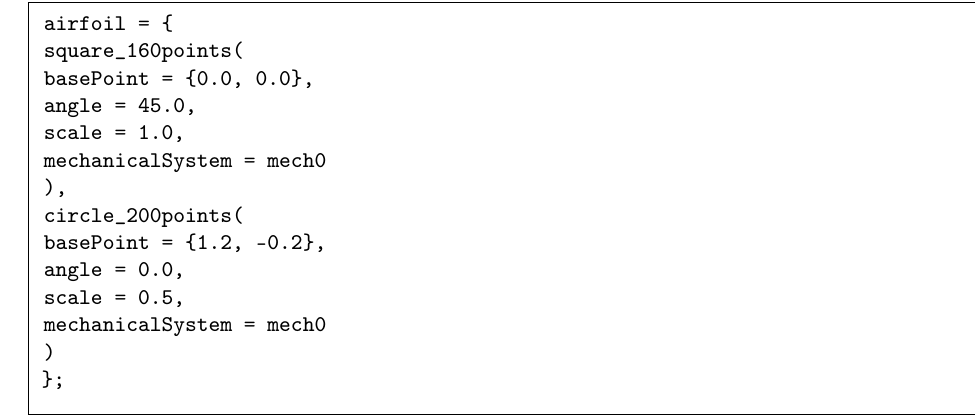
Figure 16. Code for flow around system of airfoils simulation.